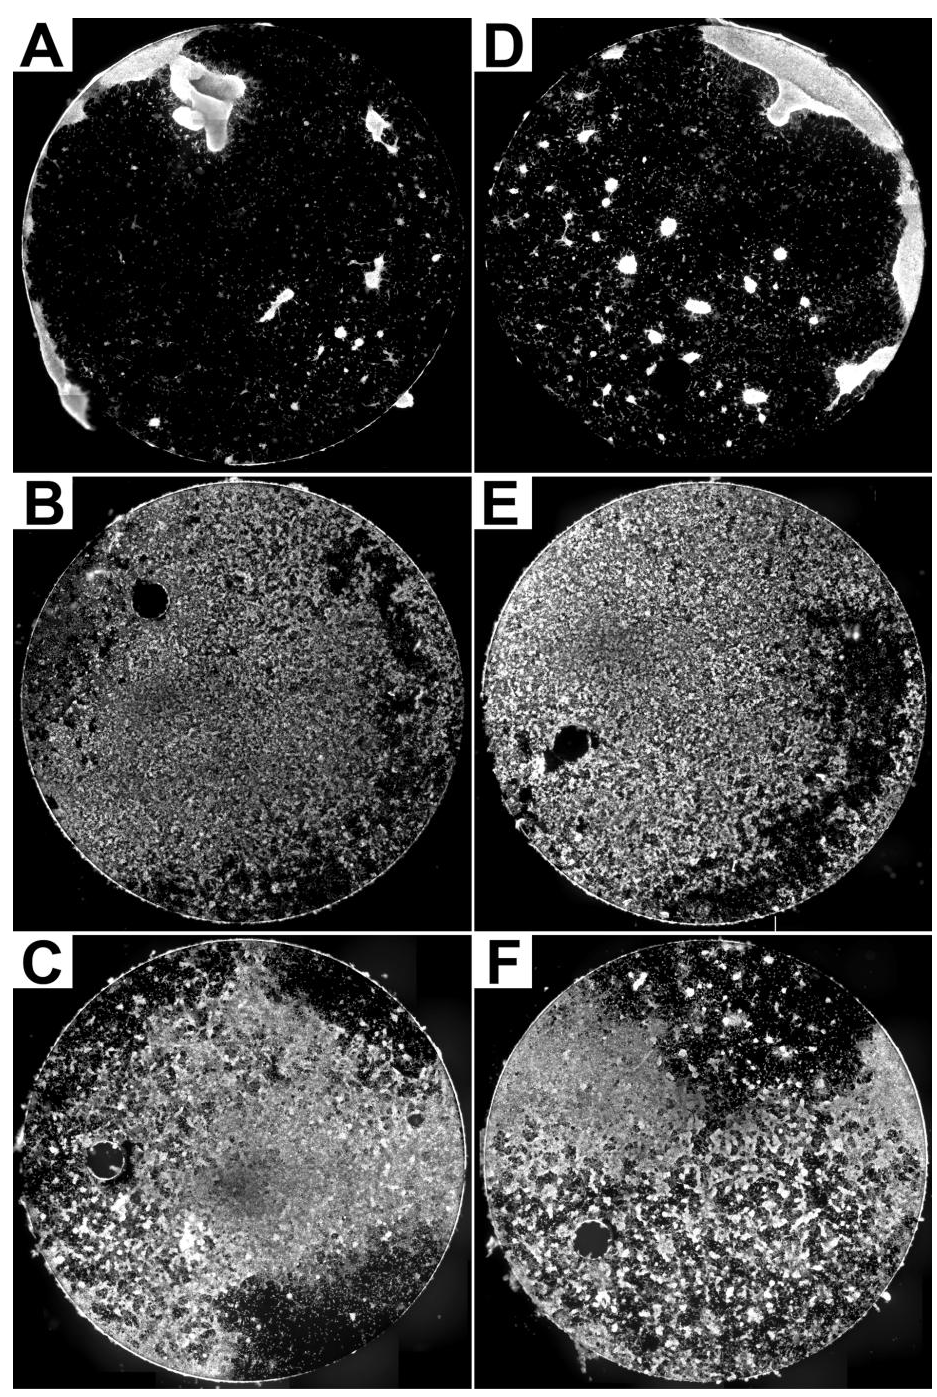
Figure 2. Examples of composite images of pairs ( A / D , B / E , C / F ) of unetched ( A , B , C ) and etched ( D , E , F ) titanium platelets where the actin of fibroblasts has been labelled by FITC-conjugated